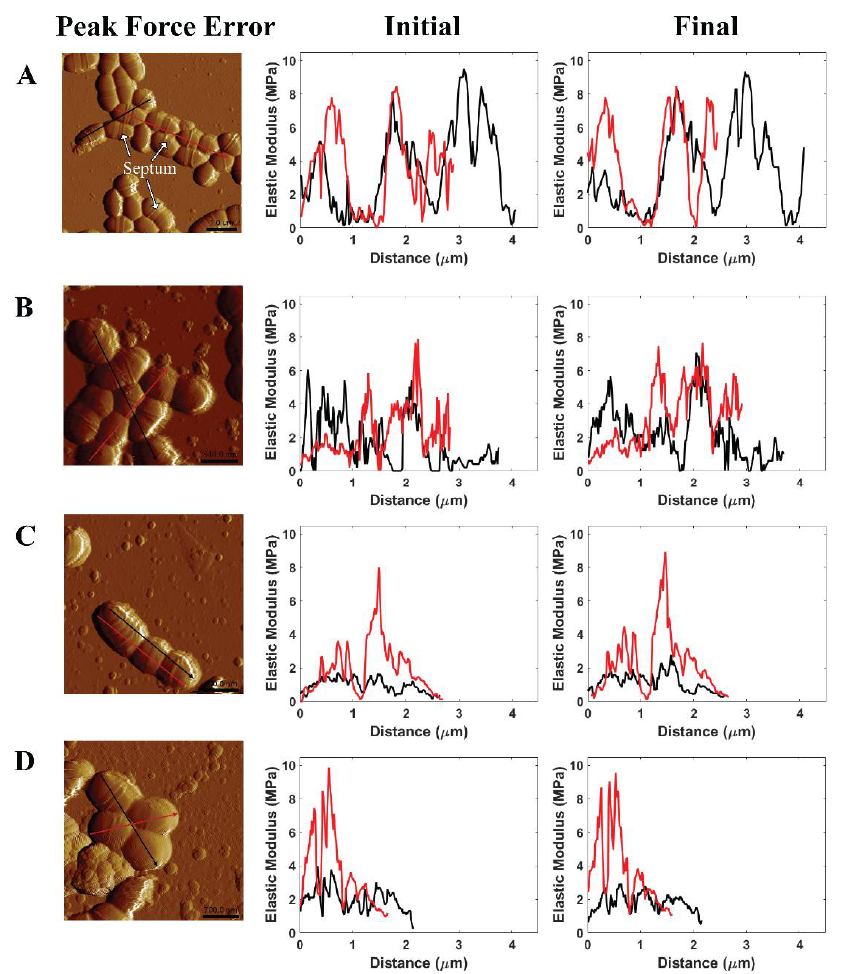
Figure 6. Illustrated AFM phase image and cross-sectional profile of the modulus of S. mutans measured in ( A ) PBS pH 7, ( B ) citric acid pH 3.3, ( C ) citric acid pH 2.3, and ( D ) citric acid pH 1.8 at the initial stage and the final stage of AFM